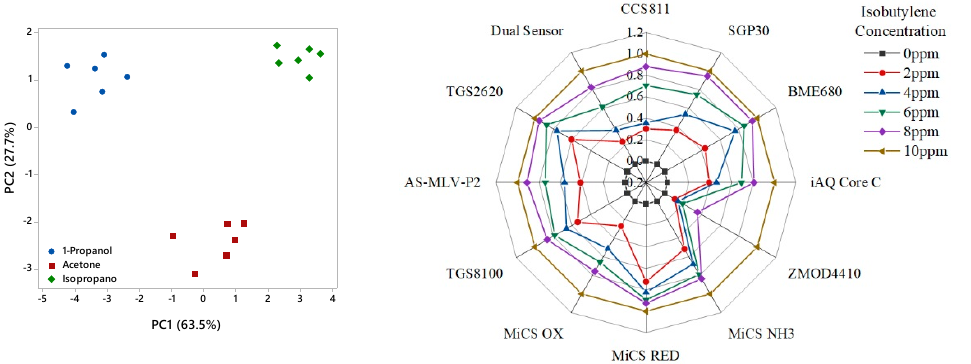
Figure 8. Testing of chemical standards; ( left ) PCA results; ( right ) Isobutylene concentration steps radar plot of normalised features.